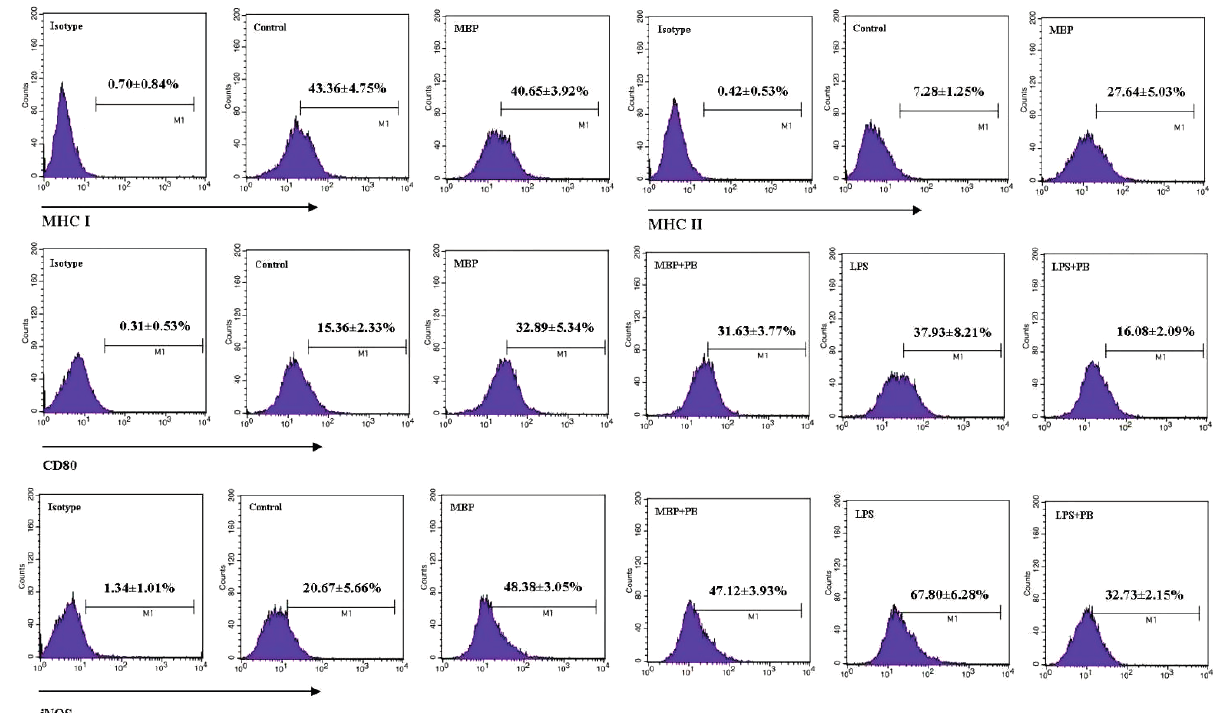
Figure 3. Effects of MBP on expression of MHC class I, MHC class II, CD80 and iNOS in RAW264.7 macrophages. RAW264.7 cells were treated with 5 μ g/mL of MBP or 1 μ